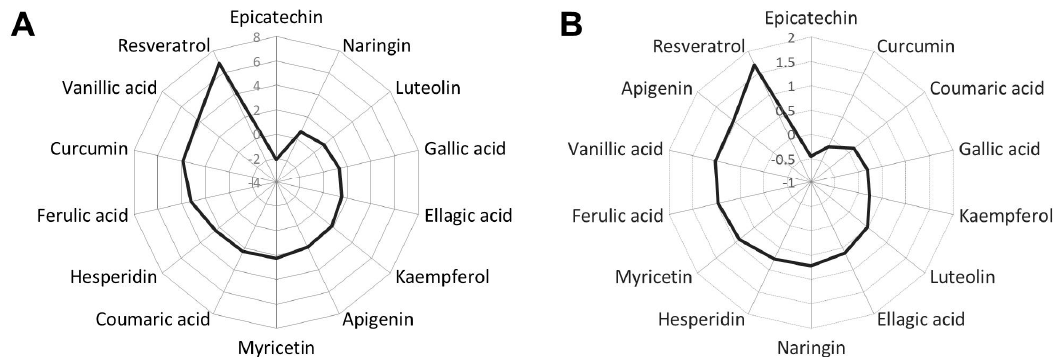
Figure 1. ( A ) Representation of the Cohen’s d effect size for the fat-reducing activity of the different phenolic compounds in C. elegans , considering Nile Red results from all doses tested. ( B ) Cohen’s d effect size of all compounds considering the low (10 µM) and medium (100 µM) doses tested.